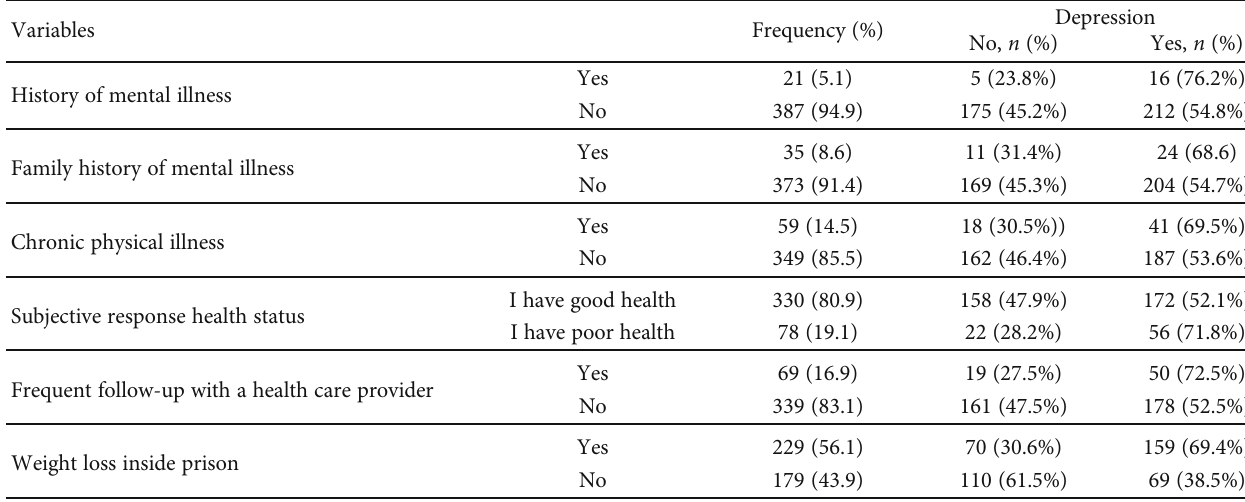
Table 2: Clinical/health-related characteristics of prisoners in Mekelle General Prison Center, Tigray, Ethiopia, 2019 ( n = 408 ).